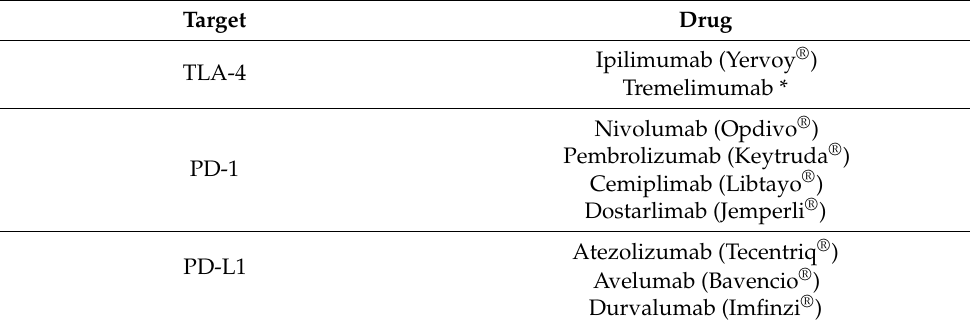
Table 1. Summary of Immune Checkpoint Inhibitors